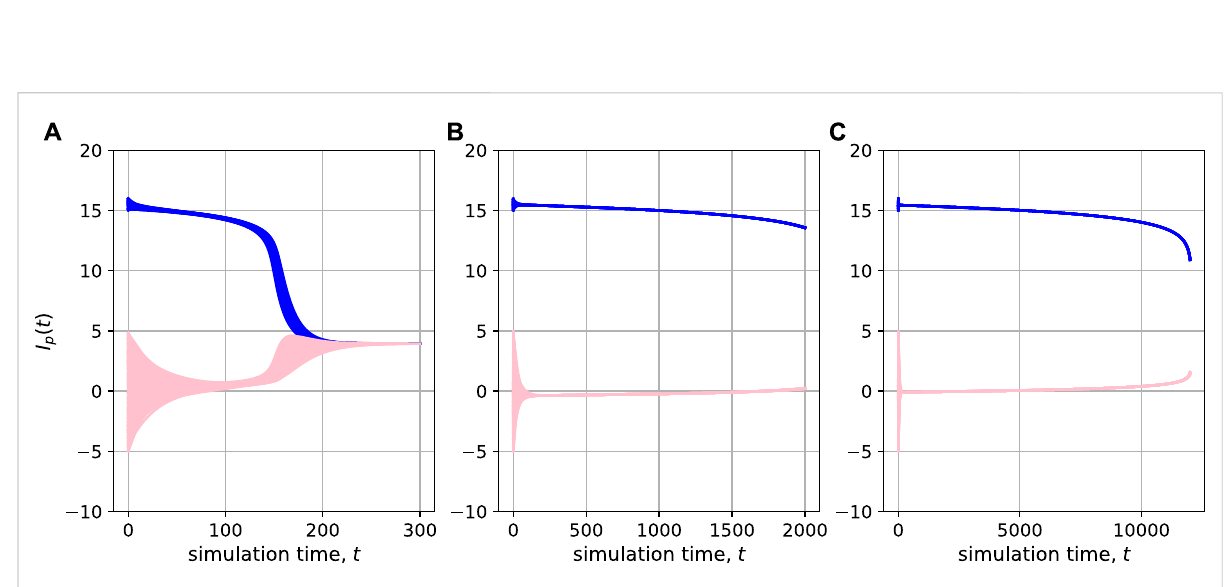
FIGURE 6 Effectofthedistanceofopinionsontheopiniondynamicsinthedensecitymodel. Eachpanelshowstheresultofasimulatedtimeseriesofthe opinions of all individuals during the simulation period. The opinions of the city inhabitants are plotted in blue, while those of the individuals outside the city are plotted in pink. Note that the simulation period is different for each panel. Here, the parameters were (| N |, α , θ , δ , γ ) = (400, 1, 0.7, 0.002, 0.5) and (| N ′ |, κ , κ 1 , κ 2 , δ ′ ) = (100, 5, 15, 16, 0.04), with (A) β = 10, (B) β = 8, and (C) β =